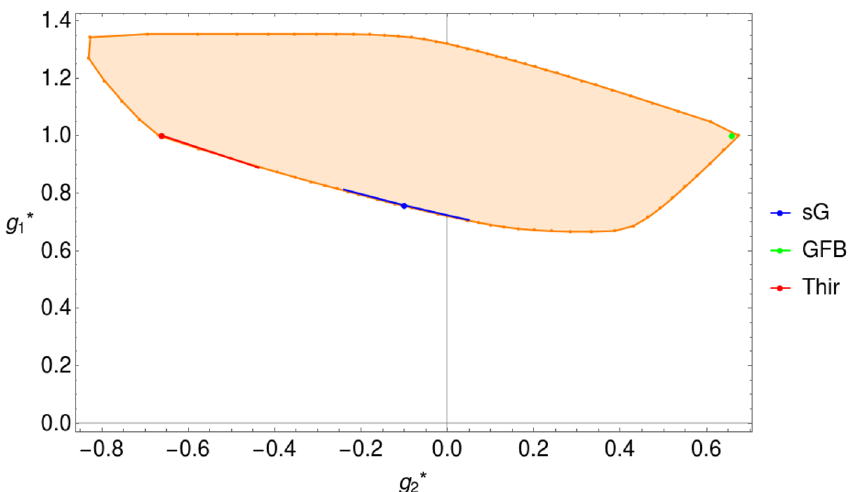
Figure 11 . Allowed region in the space of correlation function values for ∆ v = 0 . 3 with a gap of 2∆ v in all sectors. The plot is computed with Λ = 25 but it would not change significantly for higher Λ . The plot contains several interesting kinks. Two of them can be identified with the generalized free fermion in red and the generalized free boson in green. In blue, we find the correlator of boundary vertex operators with winding number 1 in the compact boson CFT with Dirichlet boundary conditions. The small segments in red and blue correspond to the first order deformations discussed